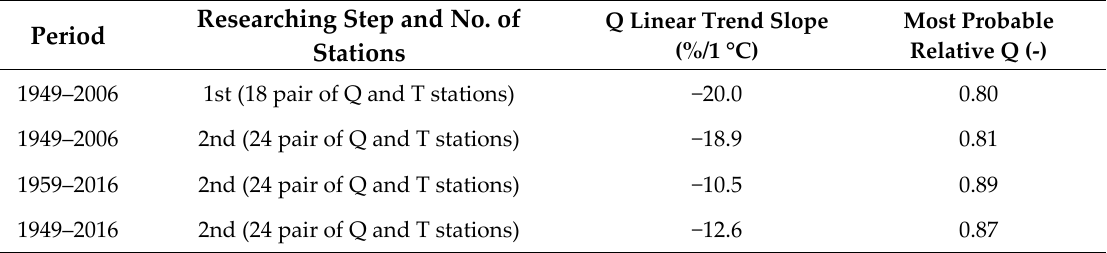
Table 5. Q linear trend slope (%/1 °C) and most probable relative Q for the years with T higher 1 °C from average of analyzed period